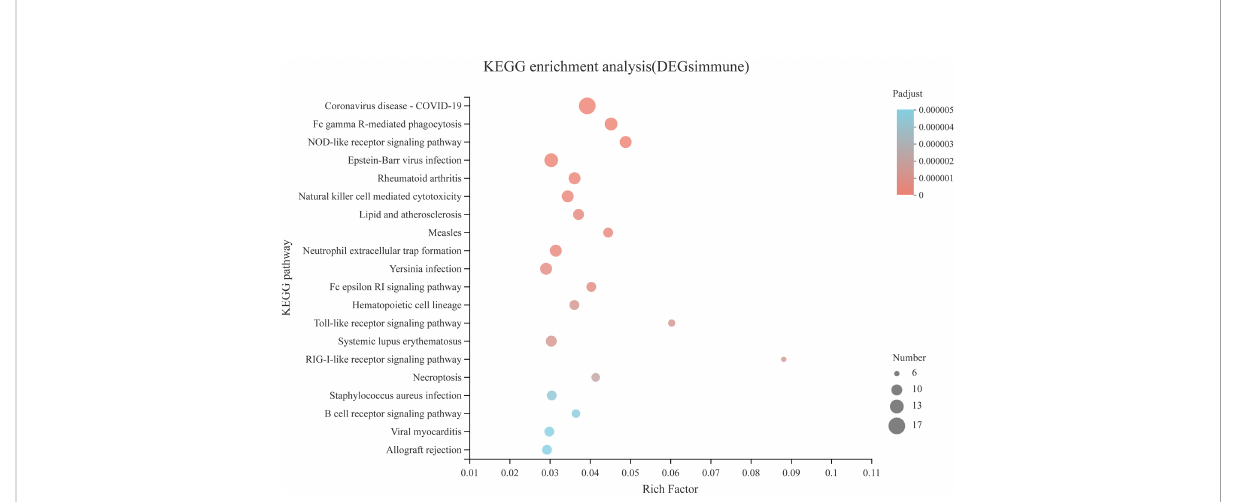
FIGURE 8 KEGG pathway enrichment analysis of the immune-related DEGs in the comparison of CON vs.